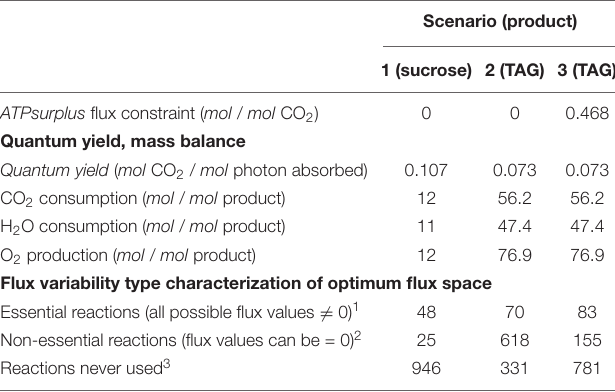
TABLE 3 | Photo-assimilation of CO 2 into sucrose or TAG using the single-cell model iTJC1414 .